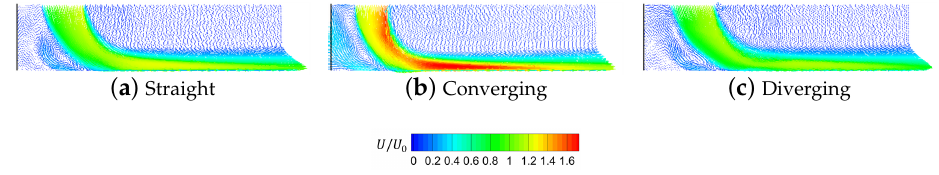
Figure 12. Velocity vector in the central r − z plane with ( a ) straight nozzle,( b ) converging nozzle, and ( c ) diverging nozzle at H = 0.5, and the vector is colored by U